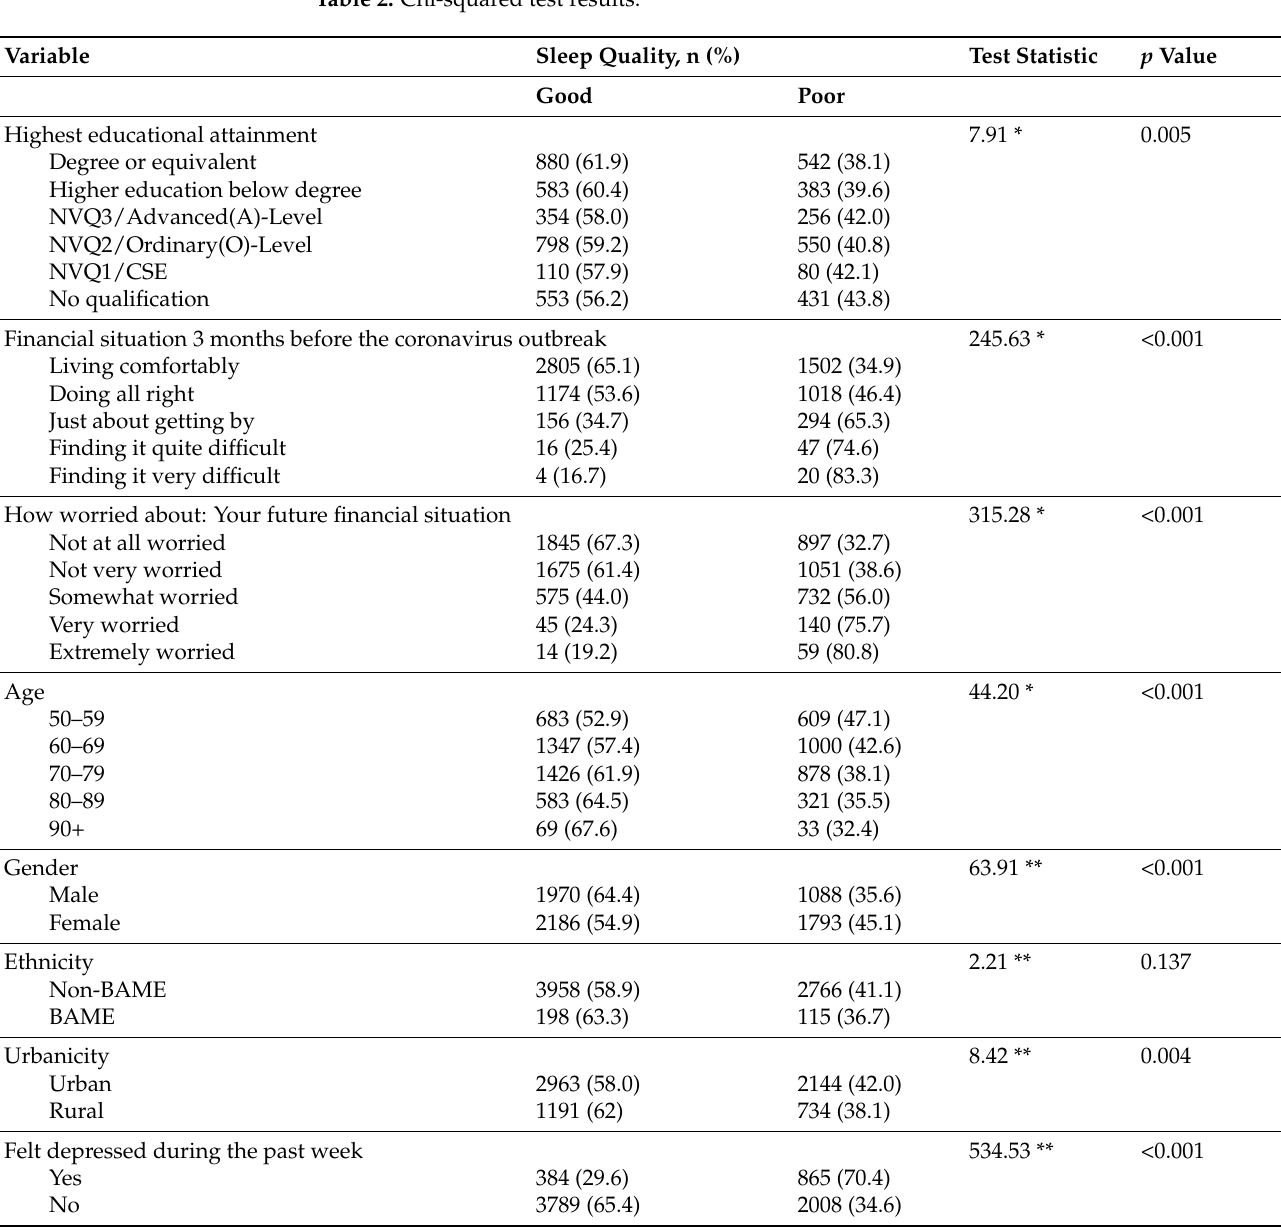
Table 2. Chi-squared test